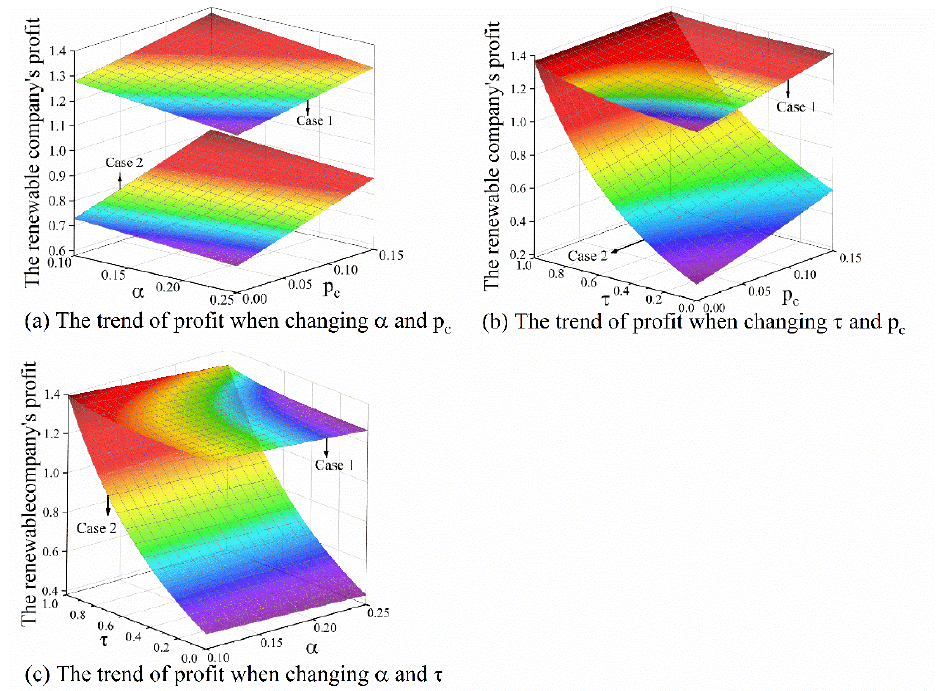
Figure 11. The renewable power generating company’s profits under different levels of α , τ , and p c .